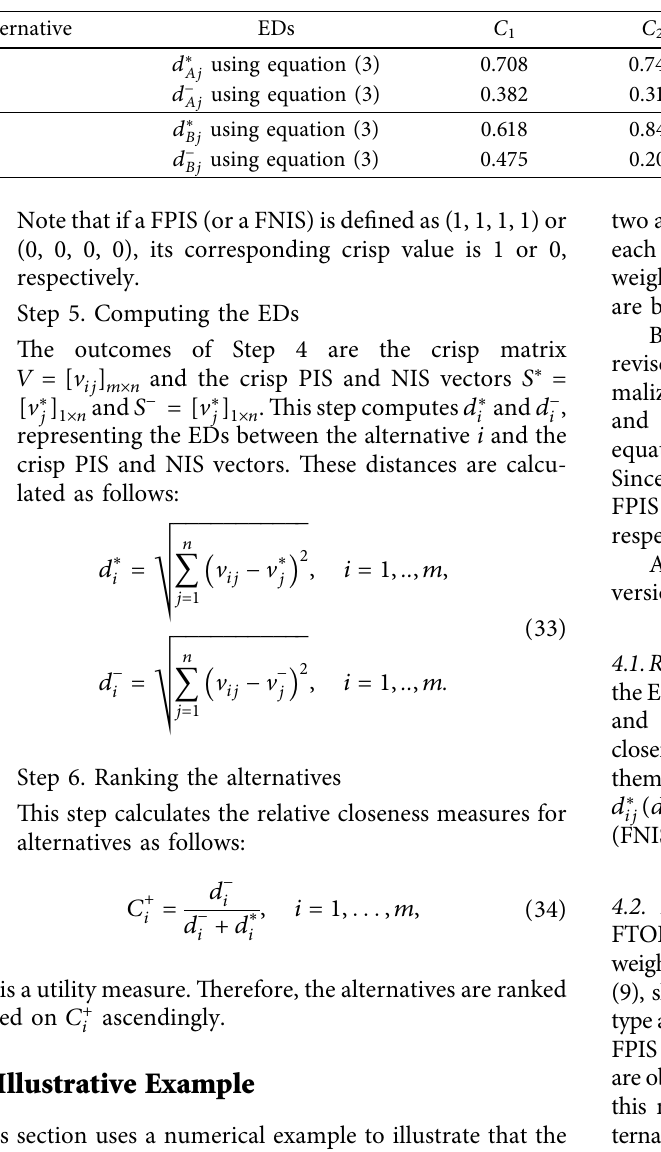
Table 4: Te required calculation based on Chen’s